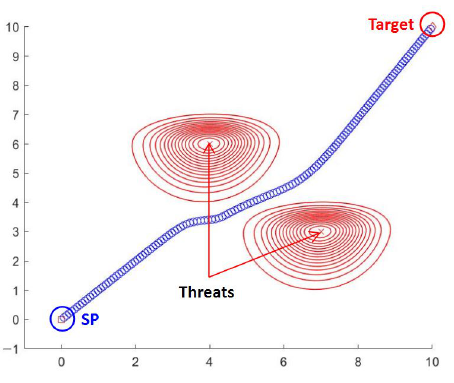
Figure 6. Path planning result for a simple instance